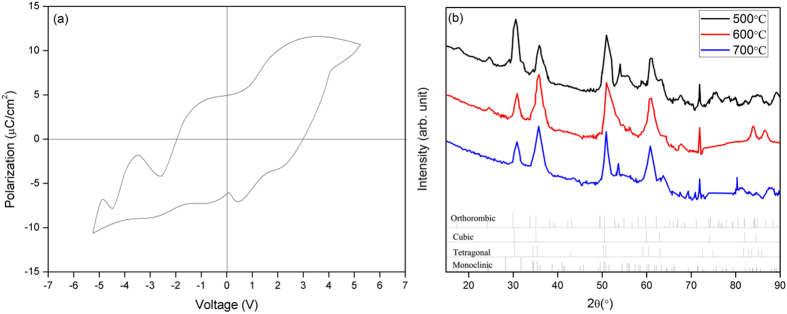
(a) P-V hysteresis measurements of the HfO2 filled into microcavities of porous silicon at 900 °C. (b) GIXRD data for a series of samples annealing at 500, 600 and 700 °C, respectively. The inset shows the standard peak position for the monoclinic, orthorhombic, tetragonal and cubic phase structure, which were used for the comparison.